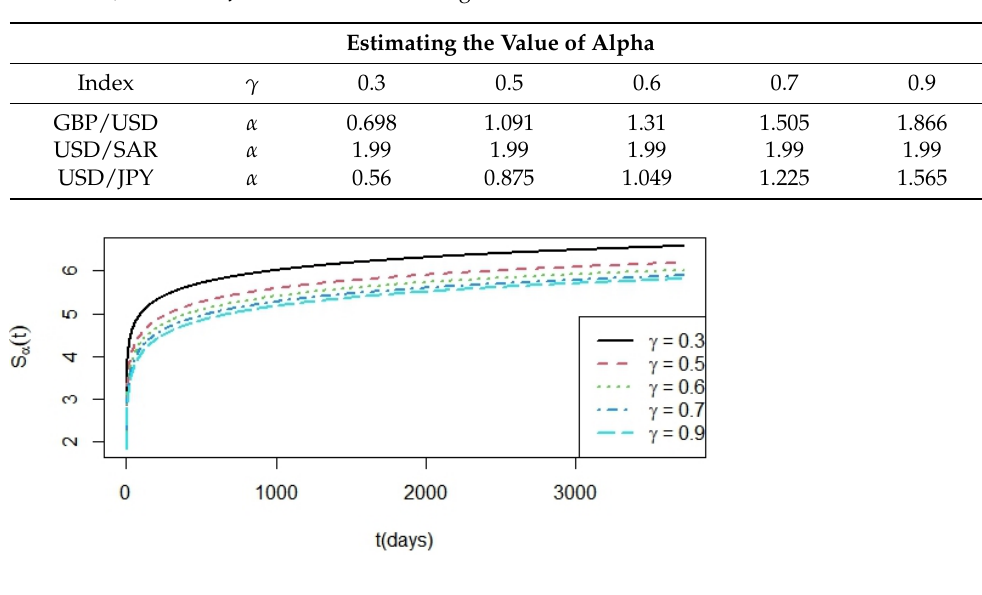
Figure 7. The entropy analysis for the GBP/USD exchange rate from 2000 to 2022 has an harmonic inverse relation with the α values (0.698,1.091,1.31,1.505, and 1.866)from Table 2, for some γ values between 0 and 1.